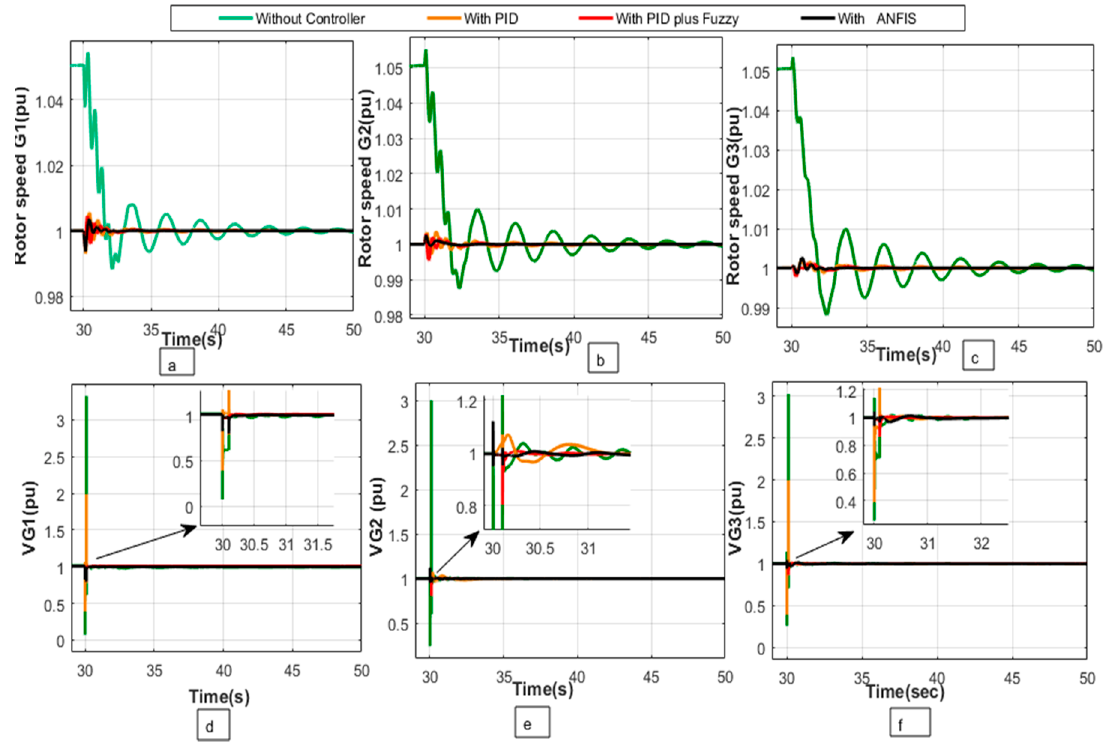
Figure 8. Studied system transient response under 3-phase short circuit fault: ( a ) SG1 Rotor speed; ( b ) SG2 Rotor speed; ( c ) SG3 Rotor speed; ( d ) SG1 terminal voltage; ( e ) SG2 terminal voltage; ( f ) SG3 terminal voltage.